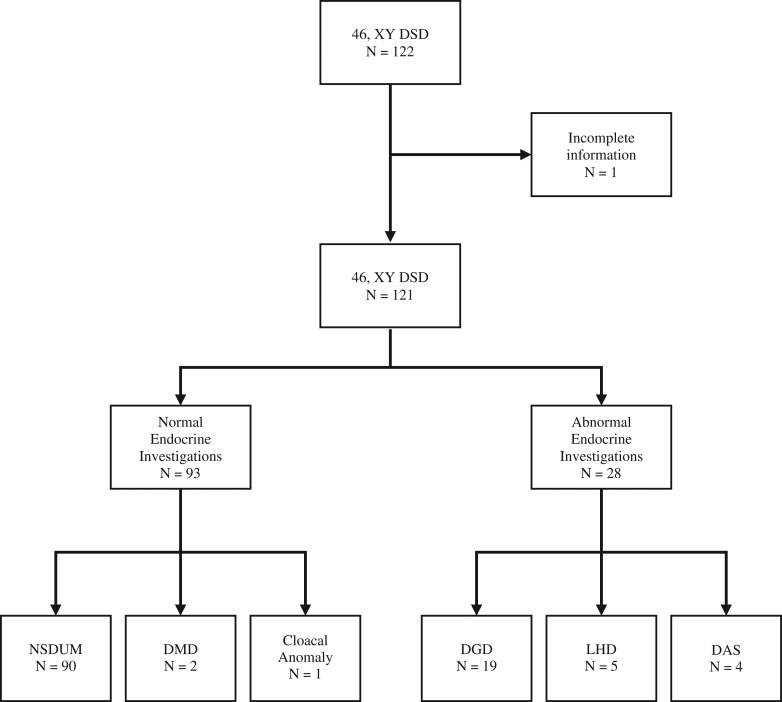
Consort diagram of 46, XY DSD boys who attended Glasgow DSD service between January 2010 and December 2015 for an assessment of atypical genitalia. Abbreviations: NSDUM, non-specific disorder of under-masculinization; DMD, disorder of Müllerian development; DGD, disorder of gonadal development; LHD, luteinising hormone deficiency; DAS, disorder of androgen synthesis.